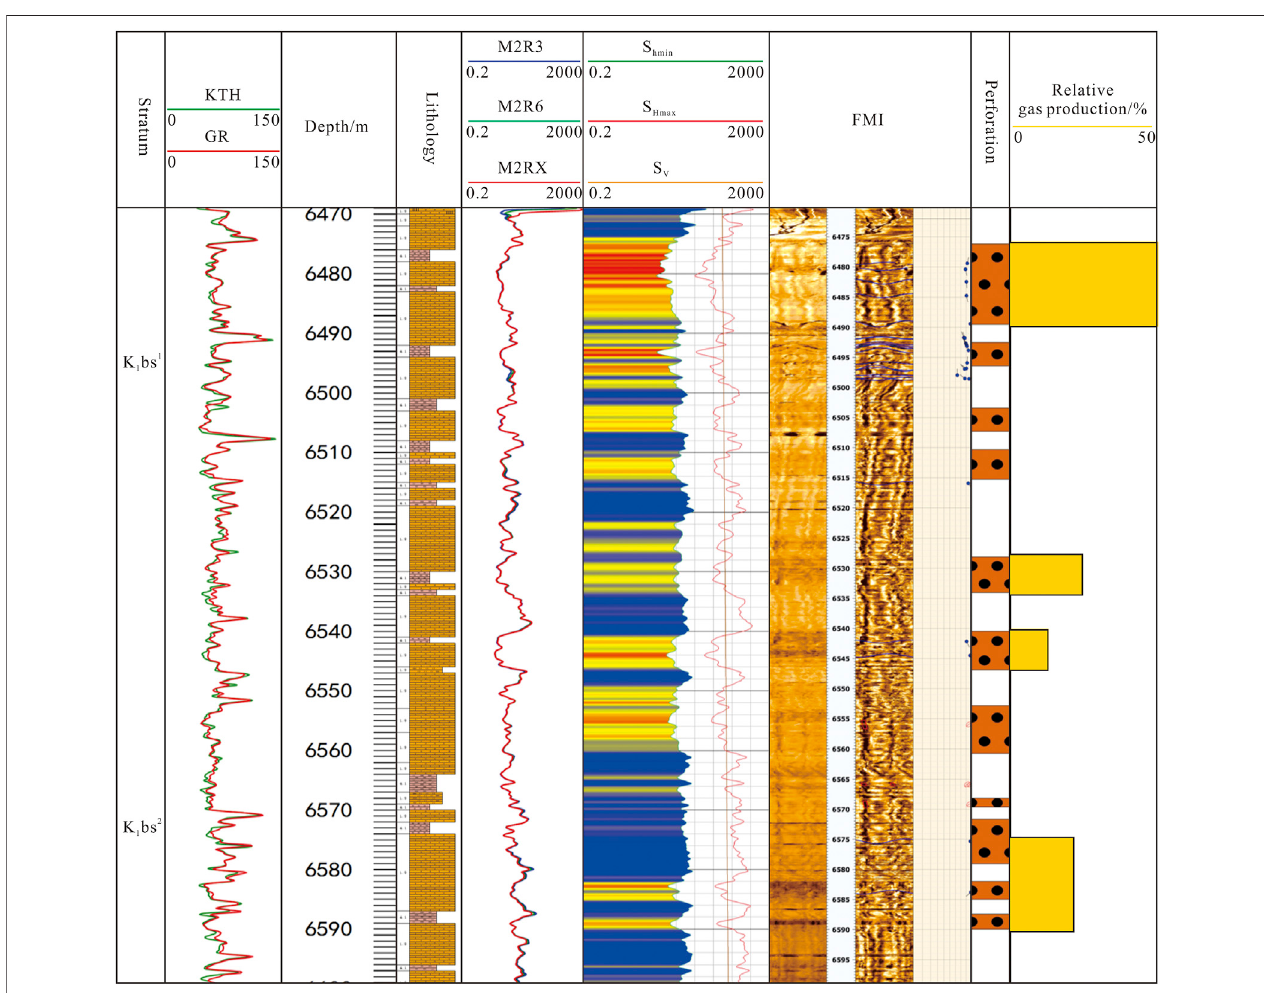
FIGURE 6 | The liquid production pro fi le of well ks24-5; The fi rst trace in the fi gure is the stratum, the KTH in the second trace is the de uranium gamma, the fi fth trace is the formation resistivity measurement results of different radial depths, m, and the sixth trace is the current in-situ stress, in which S hmin is the current minimum horizontal principal stress, MPa; S hmax is the current maximum horizontal principal stress, MPa; S v is the vertical stress, MPa, the eighth channel is the perforation position, and the ninth channel is the contribution ratio of oil and gas production of each formation,%.